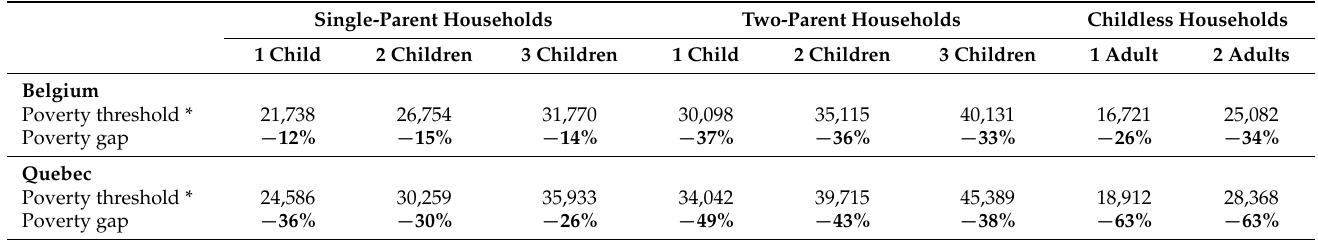
Table 2. Poverty gap among welfare households in Belgium and Quebec in 2015. Single-Parent